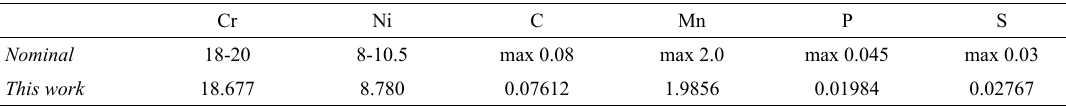
Table 2. Chemical composition of the AISI 304 steel (in wt.%) (*)